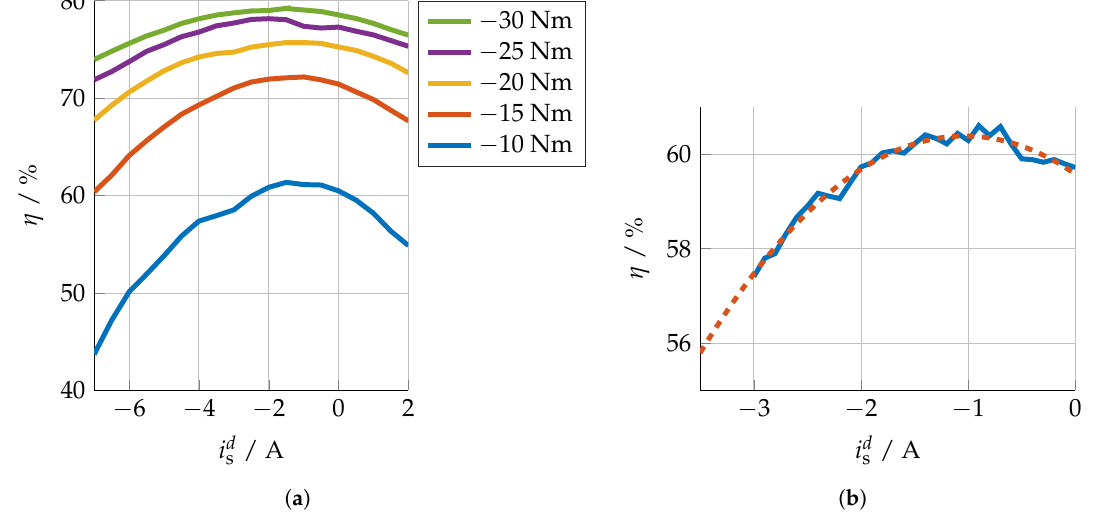
Figure 7. Measured efficiency over the direct current for a shaft speed of 200 rpm. ( a ) Roughly measured efficiency for different constant torques. ( b ) Measured efficiency ( ) and fitted polynomial of second order ( ) over the direct current i d s for a constant torque of − 10